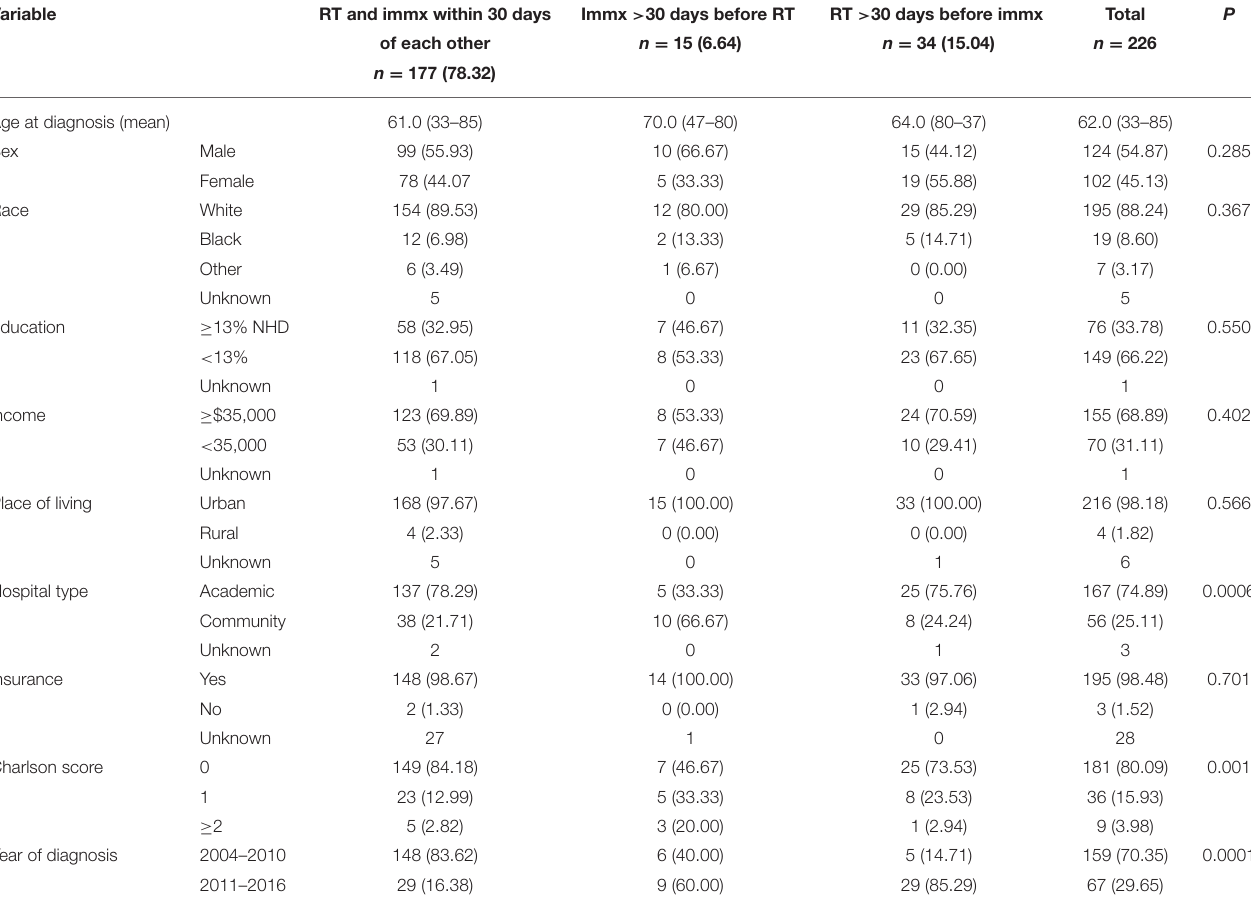
TABLE 4 | Baseline characteristics of the sequence of radiation therapy with immunotherapy in PDAC patients with no surgery.